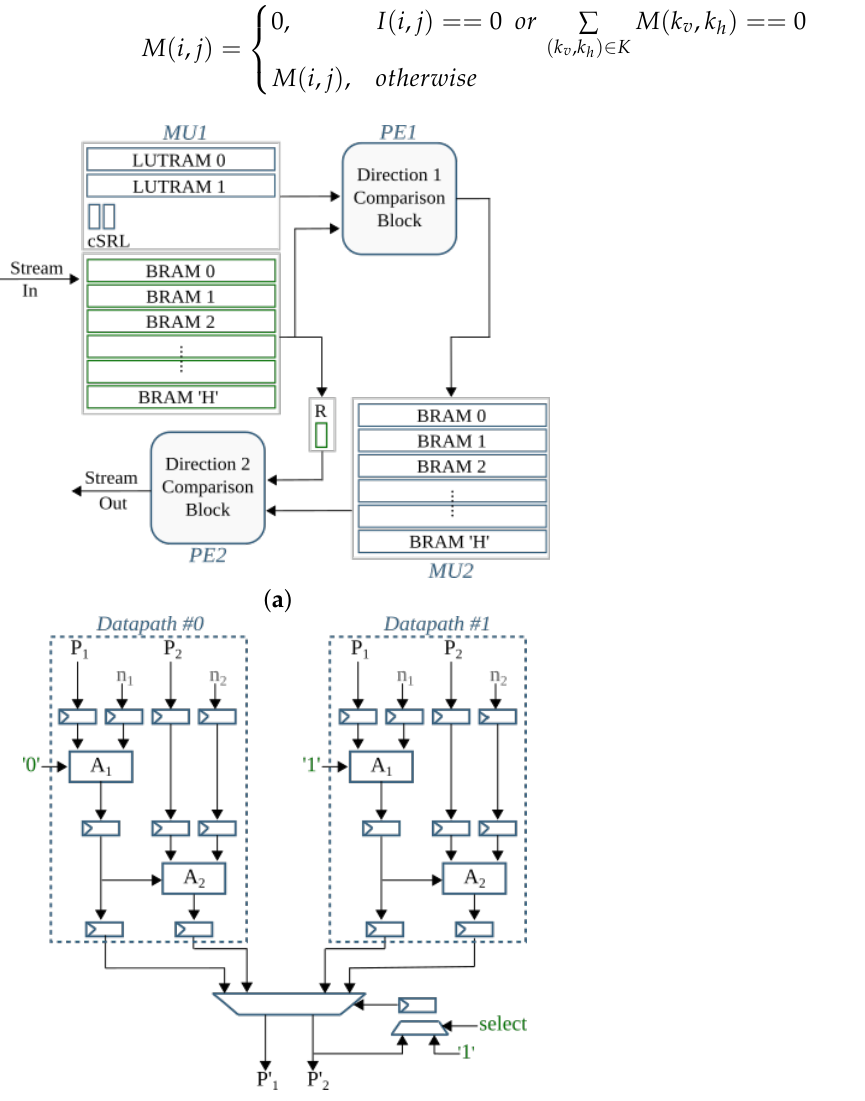
) are the corresponding neighbors. ( P (cid:48) 1 , n 2